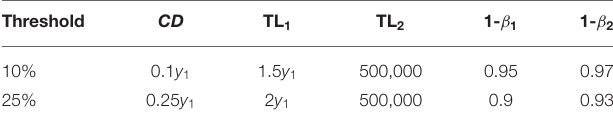
TABLE 3 | Indicators of the CII model in the basic